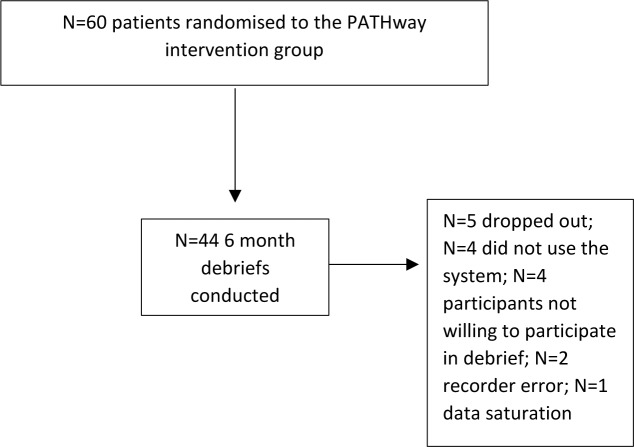
Participant flow.